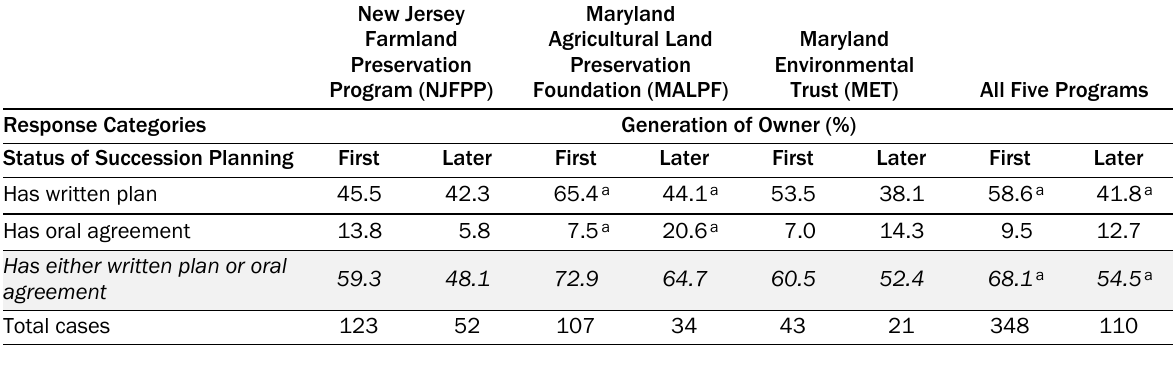
Table 6. Owner Reports on Succession Planning and Anticipated Successors, by Generation of Ownership: Exclusively First and Exclusively